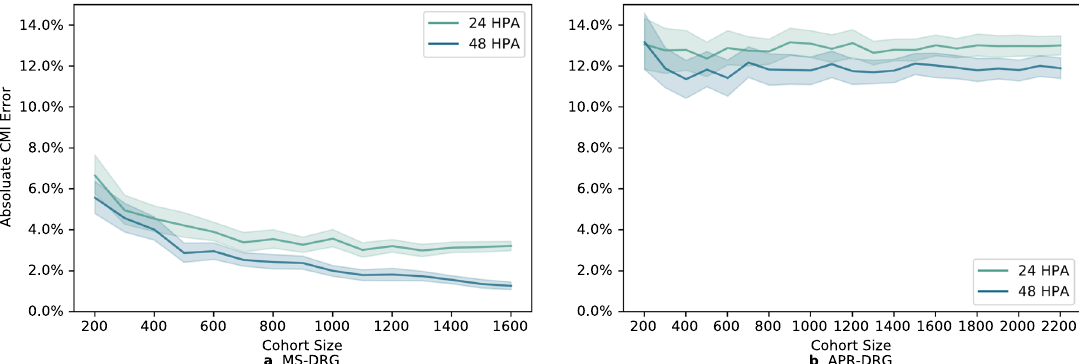
Fig. 2 CMI for patient populations of different sizes. Performance to predict CMI (mean and 95% CI, based on 100 bootstrapped samples) on 24 and 48 h after ICU admission (24 and 48 HPA) for patient groups of different population sizes, ranging from 200 to 1600 for MS-DRG and 200 to 2200 for APR-DRG. Sub fi gure a shows results on the MS-DRG and b on the APR-DRG.